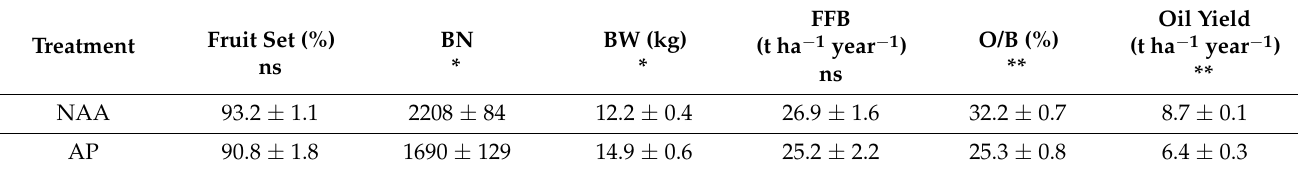
Table 8. Bunch components in OxG hybrids (Coari x La M é ) treated with 1200 mg L − 1 NAA for the induction of partheno- carpy at plantation level. The NAA solutions were applied three times staring at PS607 and reapplying at PS 609 and PS